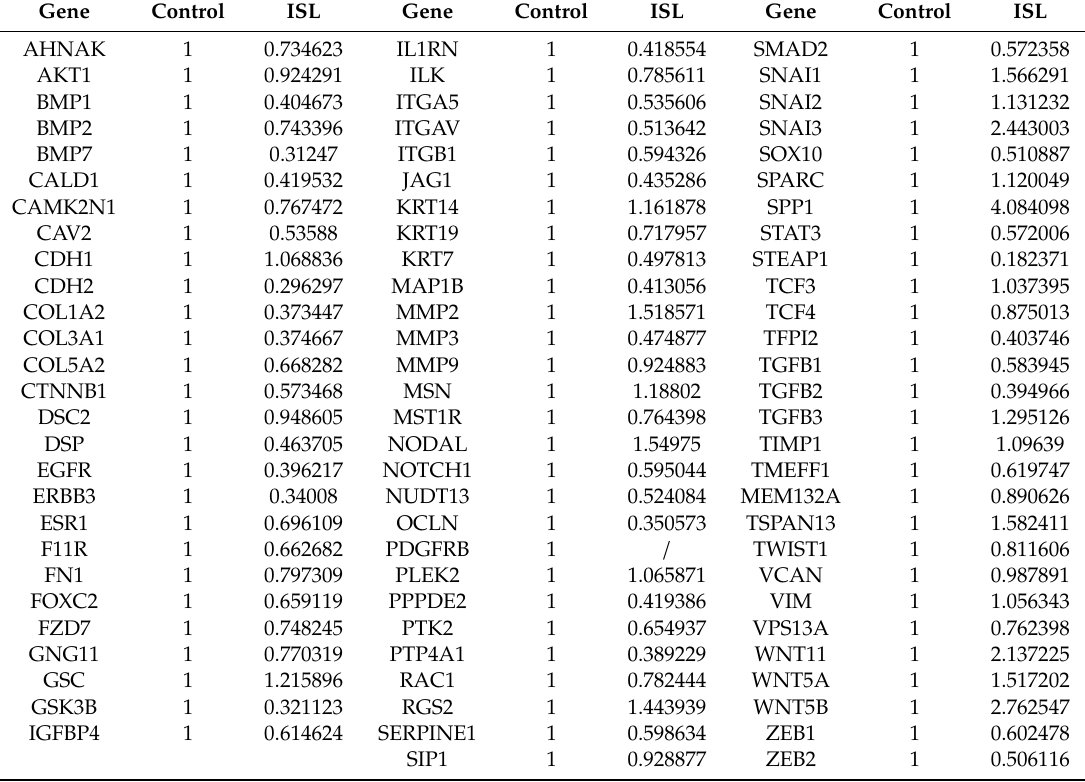
Table 1. Expression of EMT-Associated Genes in untreated (control) vs ISL-treated SKOV3 cells